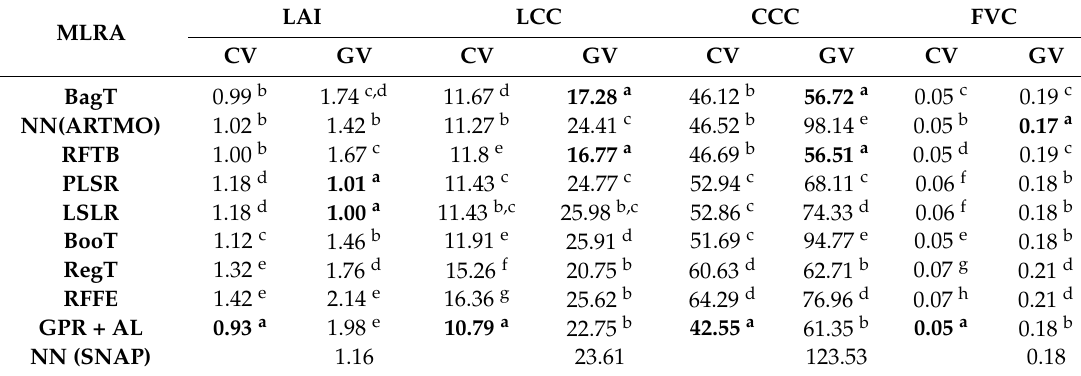
Table 5. Mean RMSE values of 10 replicates for the estimation of LAI, LCC, CCC, FVC and FAPAR using different machine learning algorithms (MLRA) for cross-validation (CV) and ground validation (GV), for the Shunyi test site. Abbreviations for the MLRAs are reported in Table 2. Values sharing the same letters are not significantly different according to Friedman’s aligned ranks post-hoc test. The best results for each variable are highlighted in